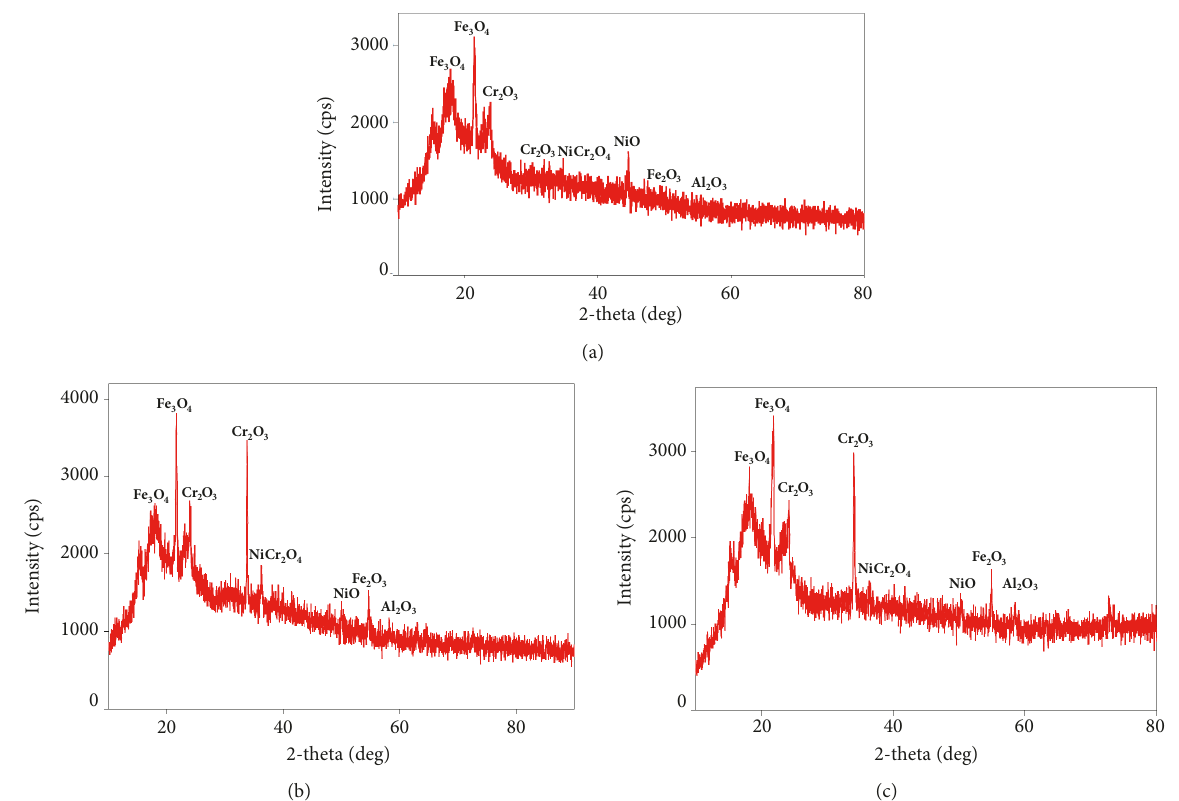
Figure 7: X-ray diffraction patterns of samples oxidized within 150 hrs. at (a) 800 ∘ C, (b) 900 ∘ C, and (c) 1000 ∘ C.